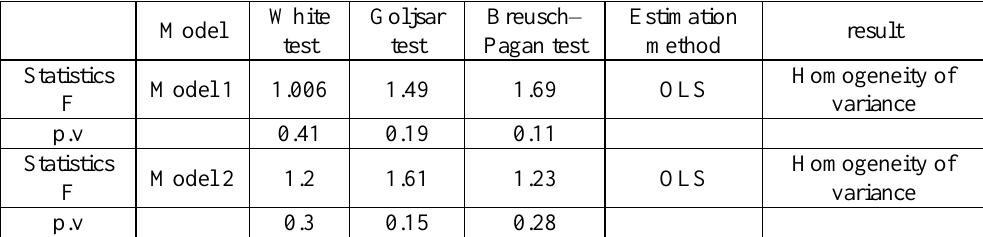
Table 5. Results of variance homogeneity test of the remnants of the regression